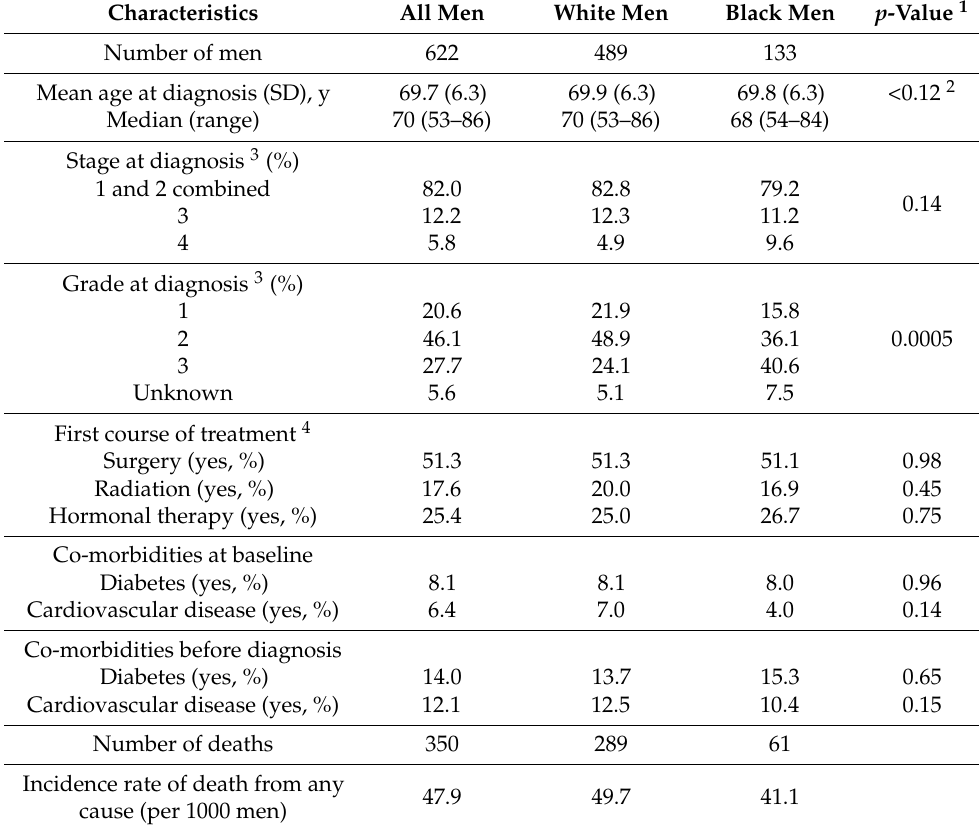
Table 1. Characteristics of men diagnosed with PC stratified by race, ARIC 1987–1989.